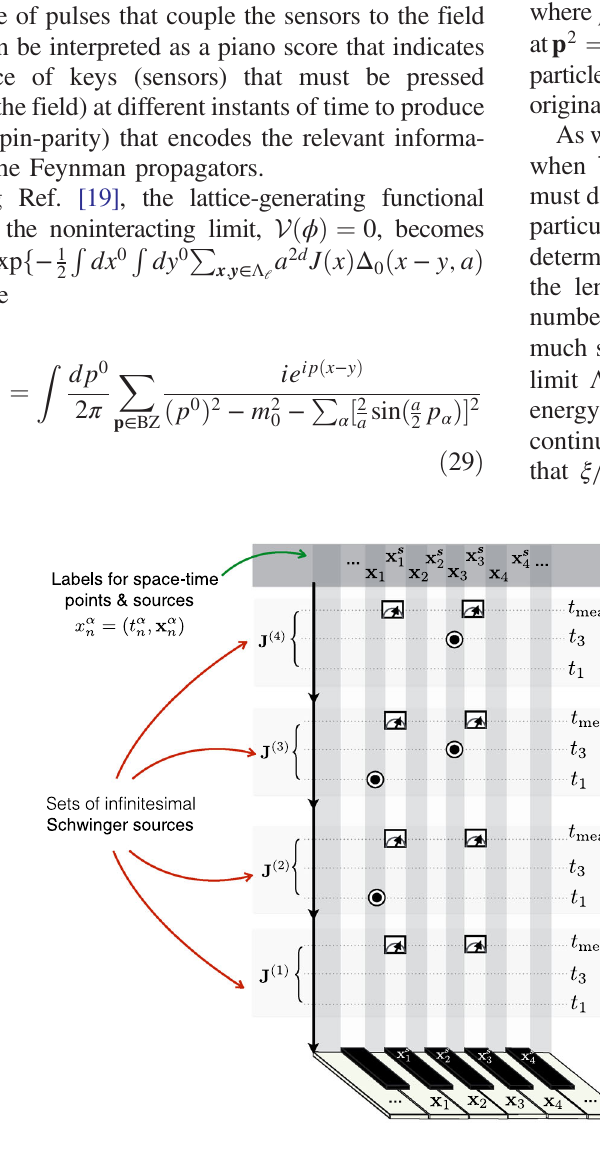
FIG. 2. Schematic representation of the quantum sensing for Feynman propagators. The different indexes for the lattice sites x ∈ Λ as well as the corresponding Z 2 sensors labeled by x s , are mapped onto the keys of a piano. The set of pulse sequences J ð m Þ that couple the sensors to the field Eq. (14) corresponds to a piano score that indicates the sequence of keys (sensors) that must be pressed (coupled to the field) at different instants of time to produce a melody (spin-parity measurement) that encodes the relevant information about the Feynman